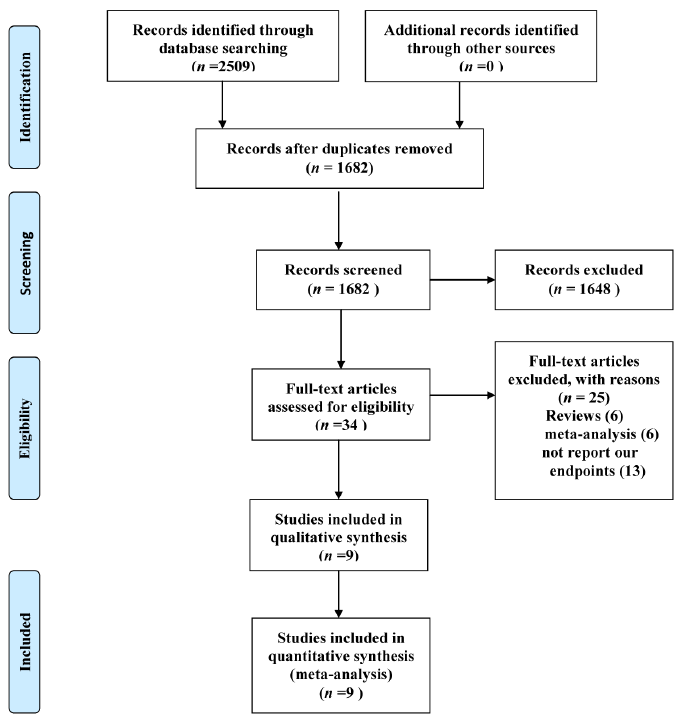
Figure 1. Preferred Reporting Items for Systematic Reviews and Meta-Analysis (PRISMA) flow diagram of study selection.